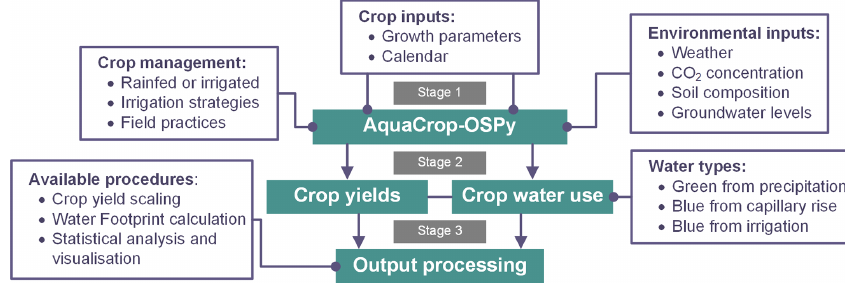
Figure 1. Schematic representation of ACEA’s simulation framework.